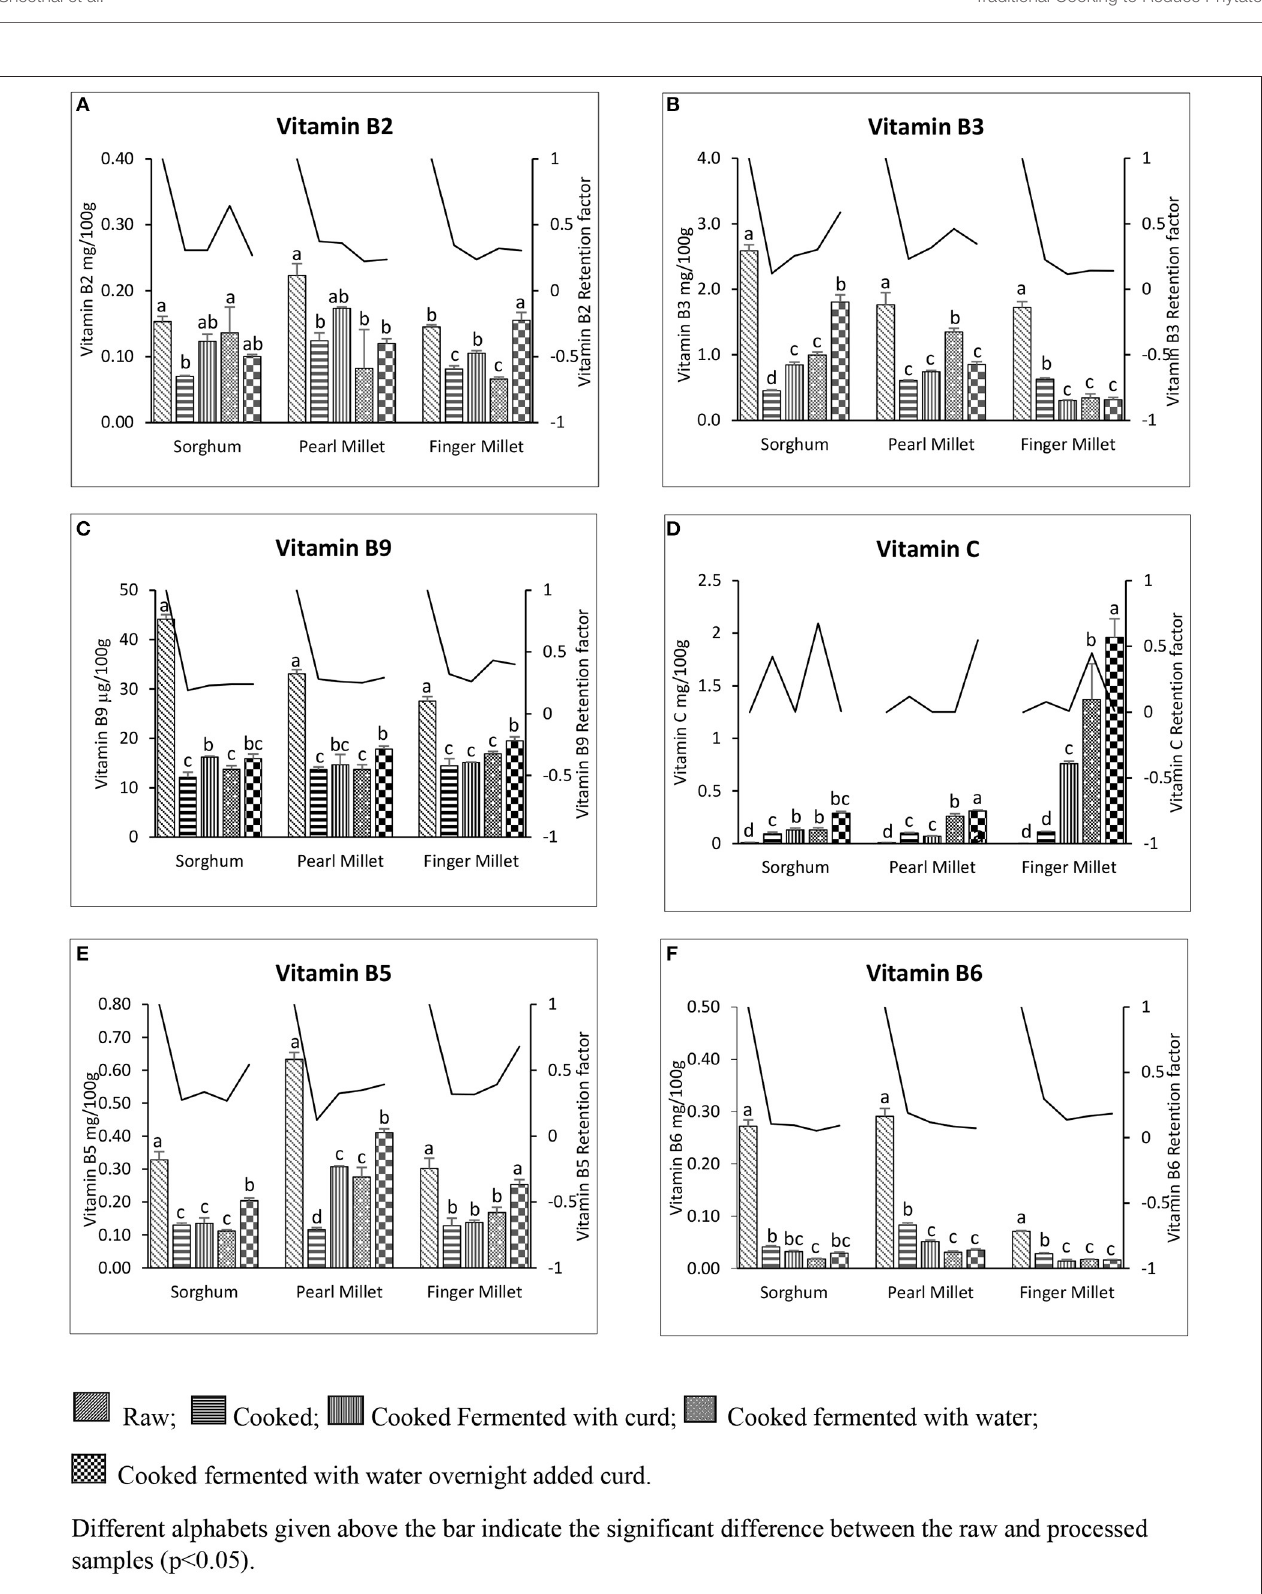
FIGURE 4 | Water-soluble vitamin concentration and its retention in the different raw and cooked millets. (A) Vitamin B2. (B) Vitamin B3. (C) Vitamin B5. (D) Vitamin B6. (E) Vitamin B9. (F) Vitamin C. Different alphabets given above the bar indicate the statistical difference between the raw and processed samples ( p < 0.005).